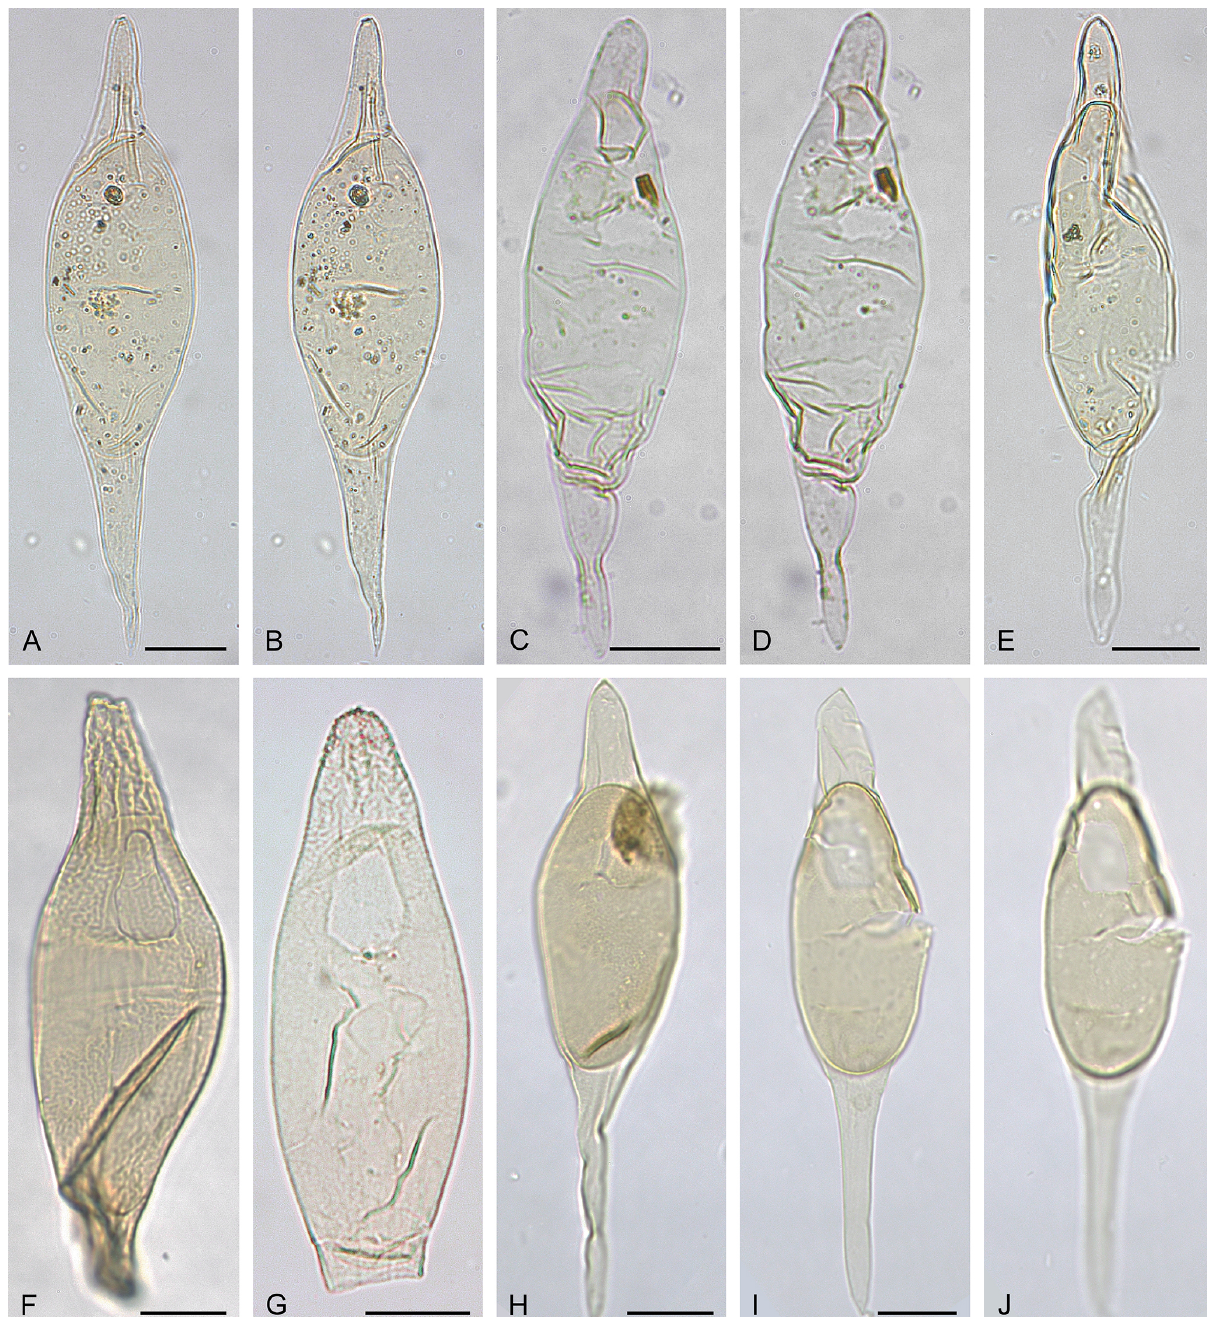
Plate 2. (A–E) Svalbardella kareniae sp. nov. (A–B) Holotype, (A) dorsal surface and (B) ventral surface; Nini-1; depth: 1100m; slide 158L-2; MGUH 33448; MC: 27 × 96 . 7; EF: T27/3; cyst length: 156.5µm. (C) Ventral surface and (D) dorsal surface; Harre-1 borehole; depth: 105.25m; slide K94F-1; EF: S53/0; cyst length: 115µm (the same specimen as photographed in ´Sliwi´nska et al., 2012; see their pl. 2.7). (E) Archeopyle is seen to the right; the Hesselbjerg outcrop section, level − 11 . 0m, slide 171K-1; MC: 25 × 99; EF: R25/1; cyst length: 143.5µm. (F–G) Svalbardella cooksoniae Manum, 1960. (F) Dorsal surface with tabulation around the cingulum; ODP Site 643, Sample 643A-50-1, 30–32cm; depth: 468.40mb.s.f.; slide 4668iv; EF: O37/3; cyst length: 123.2µm. (G) Dorsal surface with no tabulation in the cingular area; 11/10-1 well; depth: 823.0mb.s.f.; MC: 47 . 5 × 104 . 5; EF: L48/3; (H–J) Svalbardella kareniae sp. nov. (H) Paratype, dorsal surface, ODP Site 643, Sample 643A-40-1, 55–57cm; depth: 371.95mb.s.f.; slide 4879iii; PMO: 235.064; EF: M43/3; cyst length: 161.7µm. (I) Ventral surface, (J) dorsal surface; ODP Site 643, Sample 643A-40-1, 55–57cm; depth: 371.95mb.s.f.; slide 4879iii; EF: K42/0; cyst length: